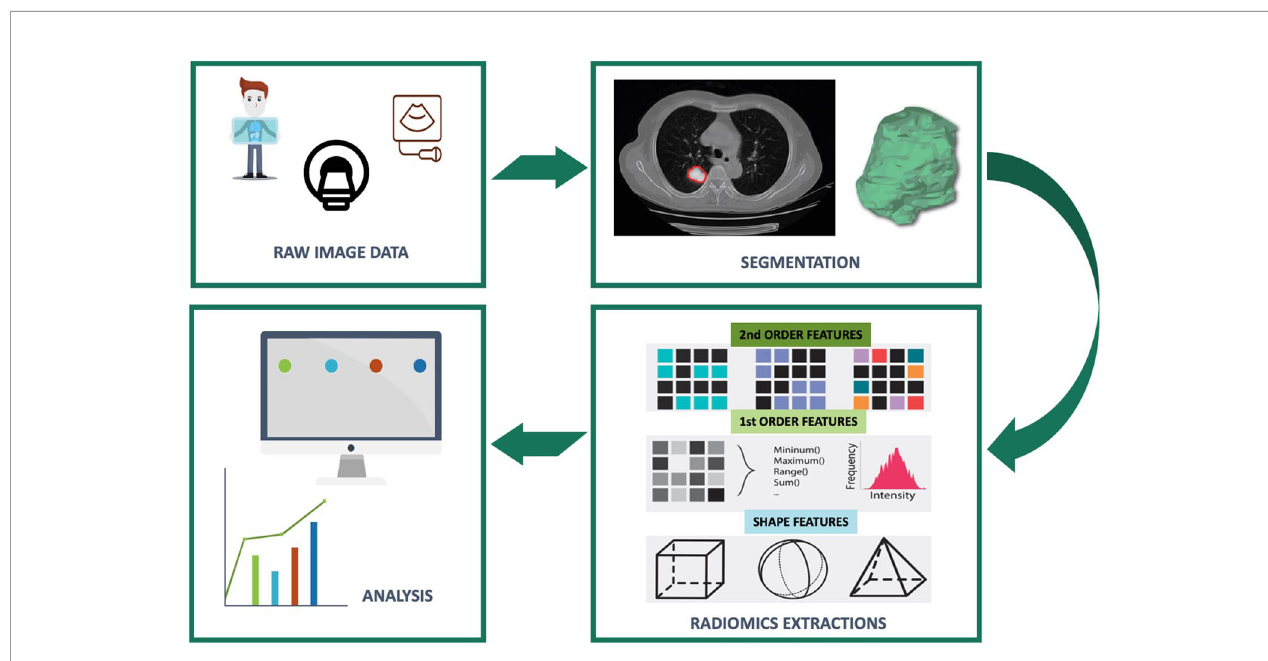
FIGURE 1 | Flowchart of radiomics feature based